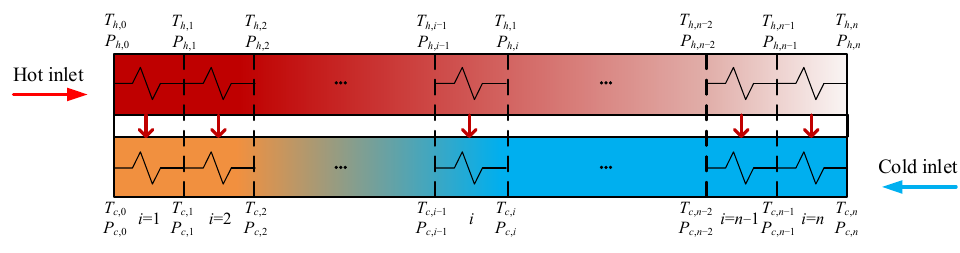
Figure 4. Schematic diagram of SEG method.